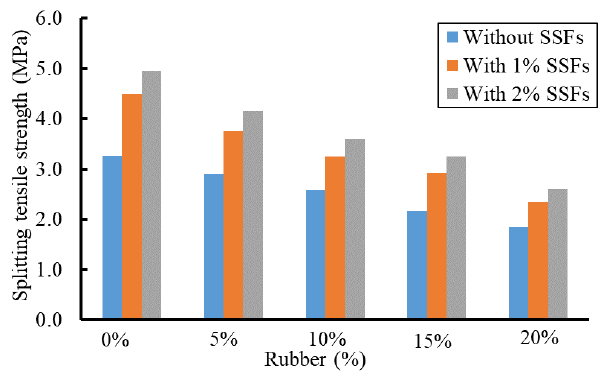
Figure 25. Results of the indirect tension tests.